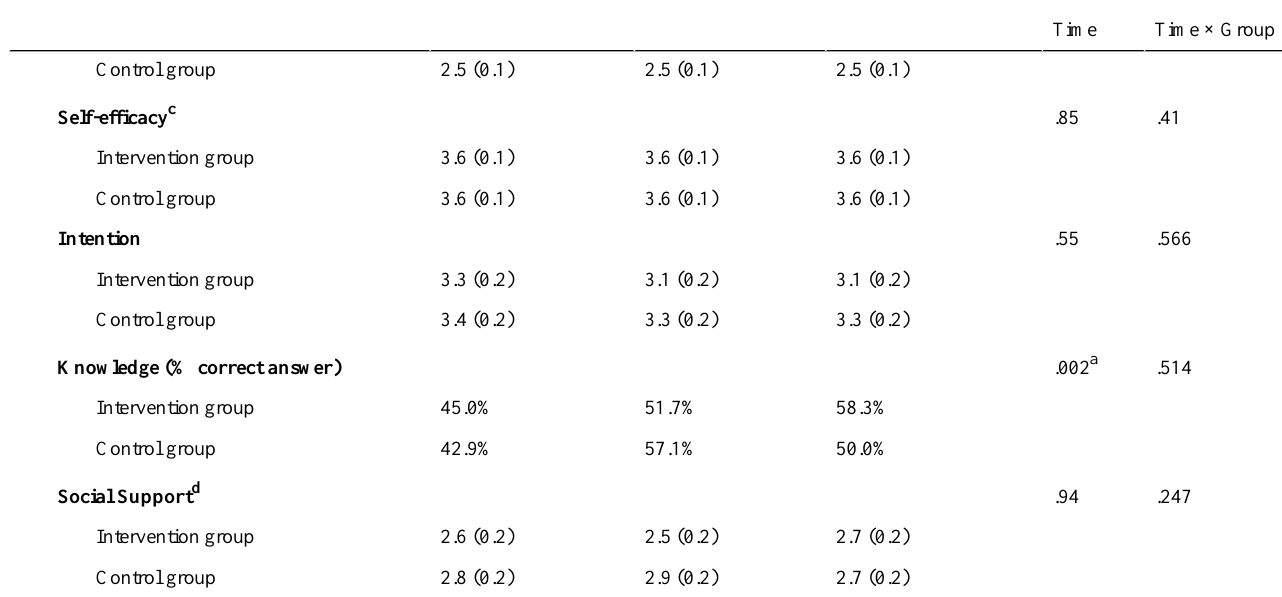
Table 4. Opinions about the use of the Fitbit Charge wearable and the Active Coach app in the intervention group. Fitbit